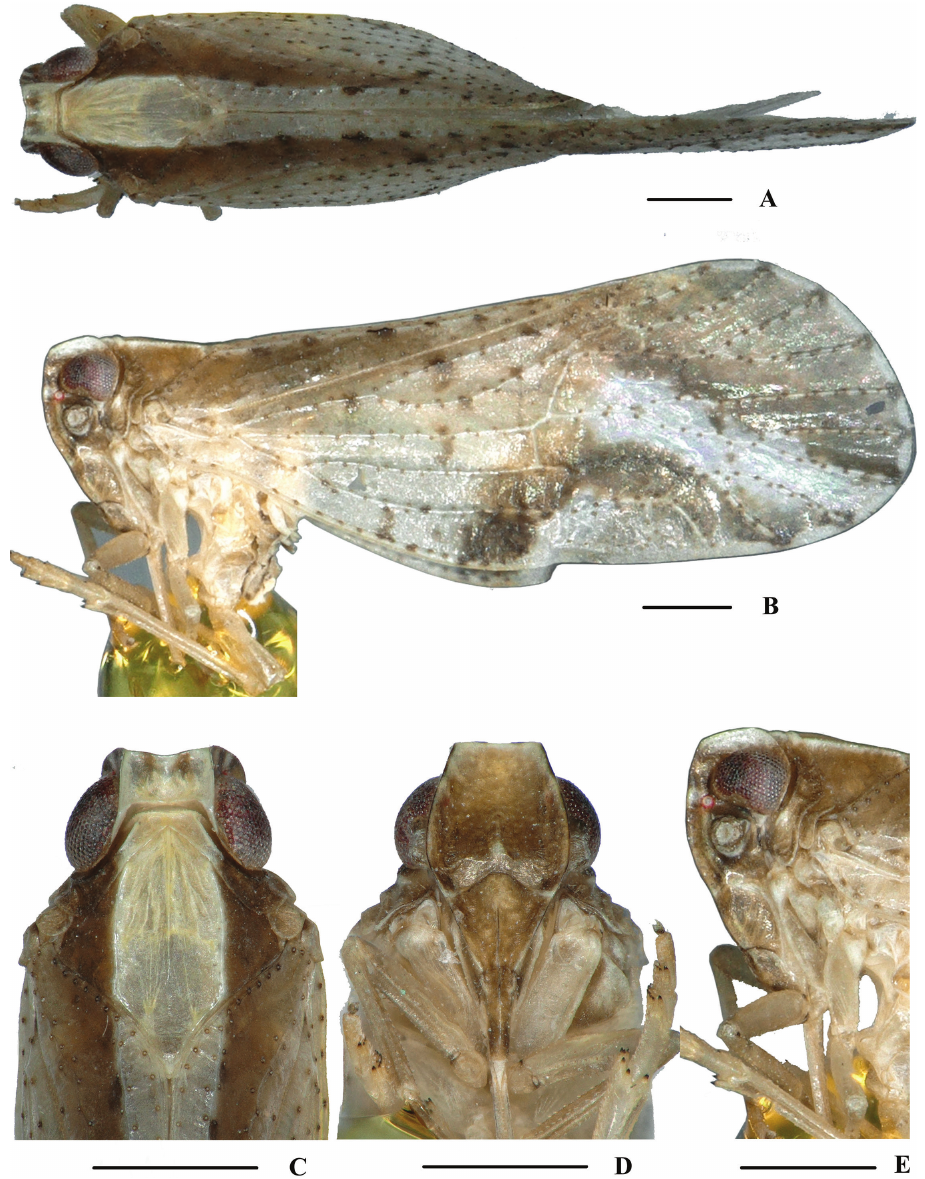
Figure 4. Kirbyana furcata sp. nov., male A habitus, dorsal view B habitus, lateral view C head and thorax, dorsal view D face, ventral view E head, lateral view. Scale bars: 0.5